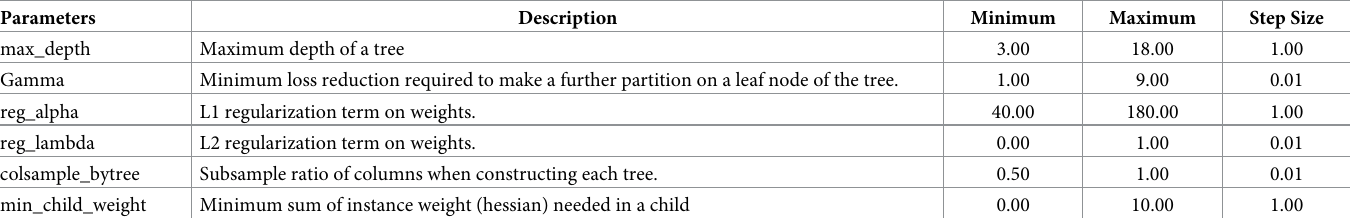
Table 3. Hyper-parameter search grid.